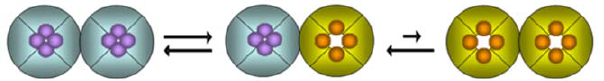
Figure 3. Proposed mechanism for noise control in K ATP channel gating. K ATP channels (sectors, SUR1; circles, Kir6.2; open state, yellow/orange; closed state, blue/purple) are colocalized (tran- siently or stably). Occupancy of one channel in the open state favors closed state occupancy of its neighbor, mitigating large fluctuations in channel gating and decreasing the total